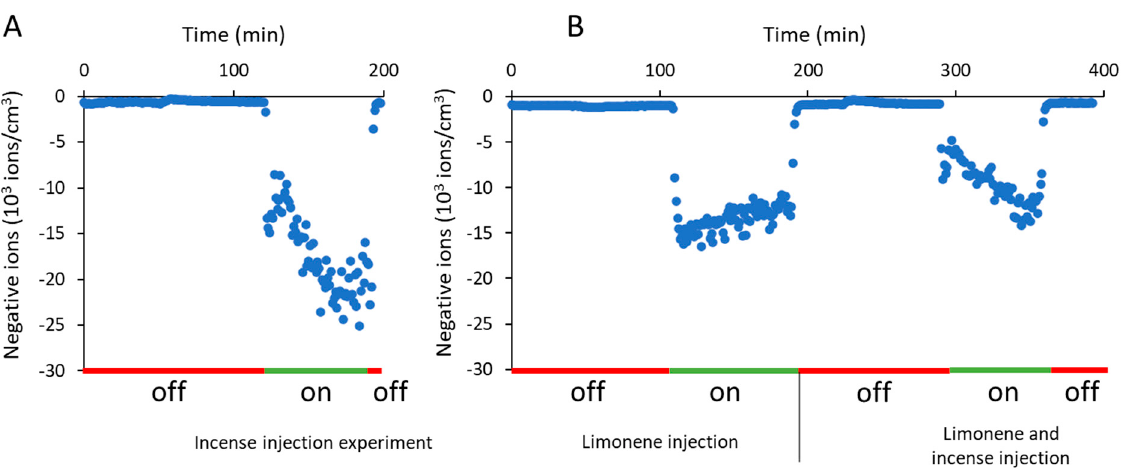
Figure 11. Ion concentrations (negative mode) measured during controlled laboratory studies at Portland State University over day 1 (panel ( A )) and day 2 (panel ( B )). On day 1, a perturbation was conducted over a 200 min period using incense burning to elevate particle concentrations, also causing increases in some VOCs. On day 2, two perturbation tests were conducted over a 400 min period: first using limonene followed by simultaneous incense burning and limonene injection.